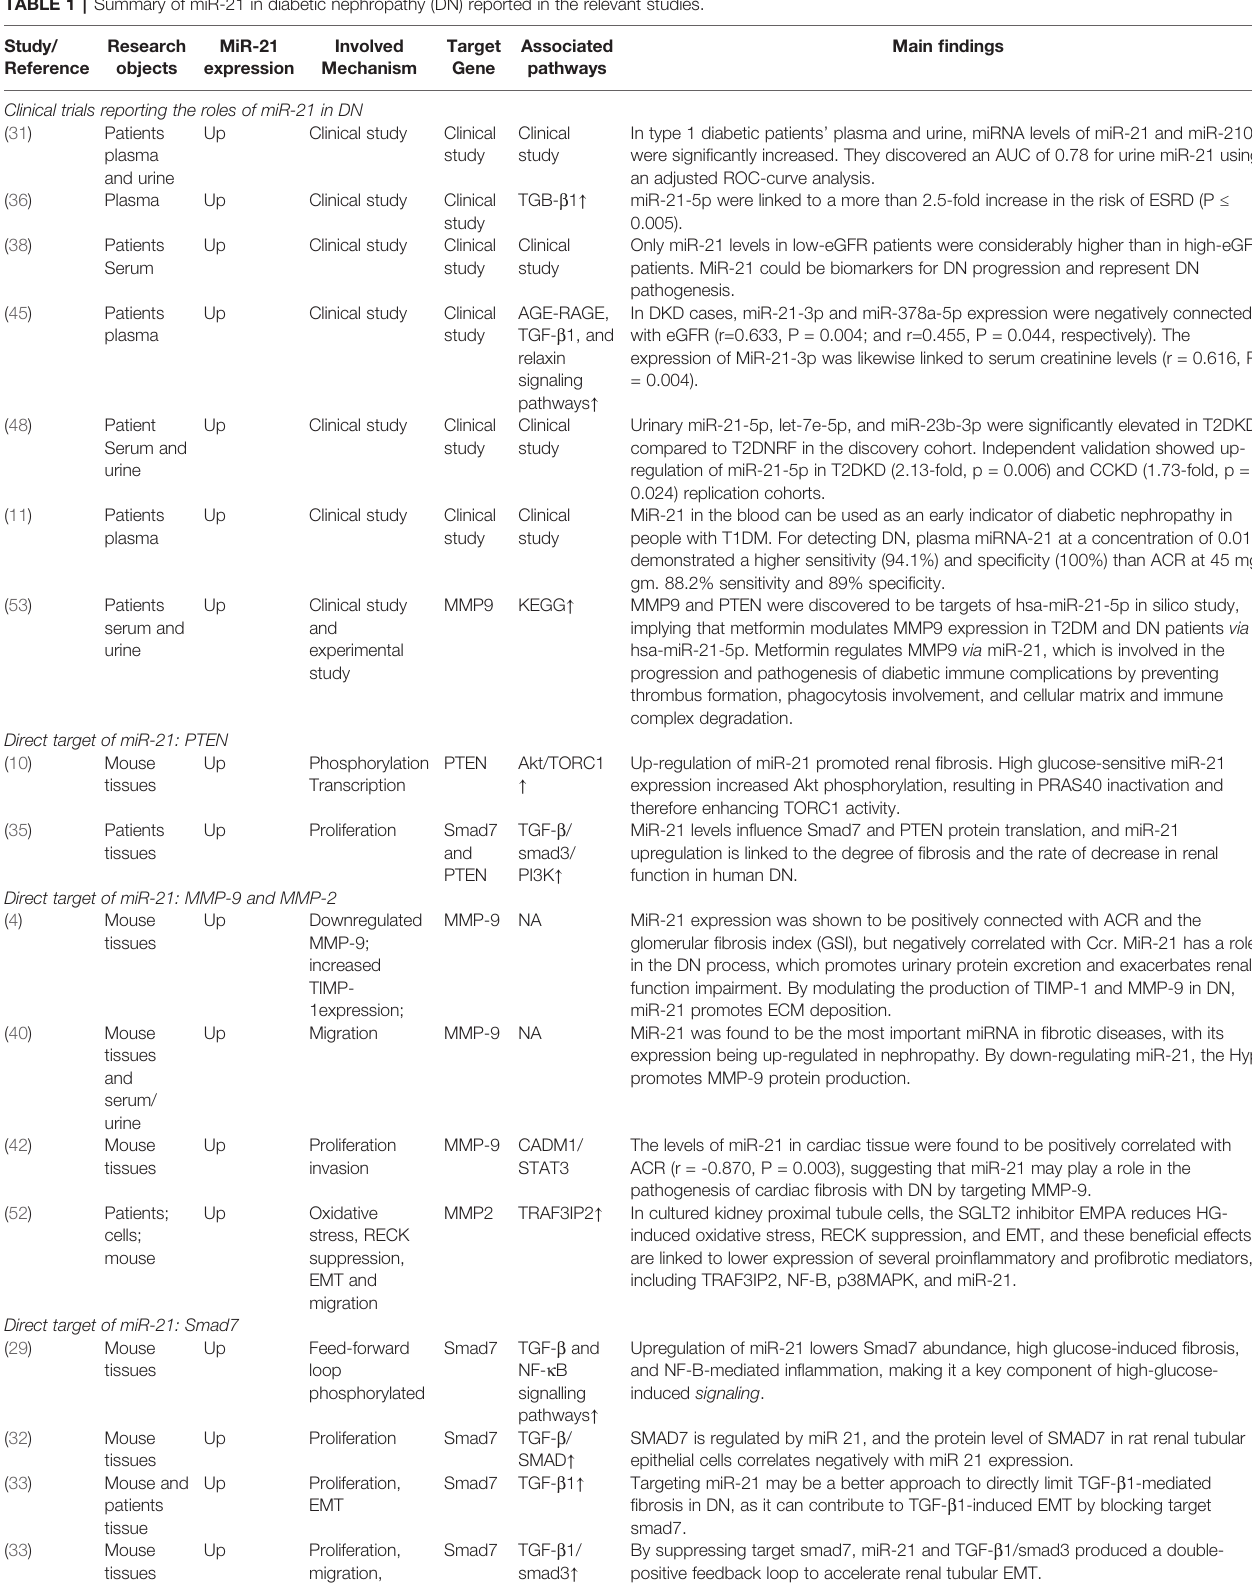
TABLE 1 | Summary of miR-21 in diabetic nephropathy (DN) reported in the relevant studies. Study/ Research Reference